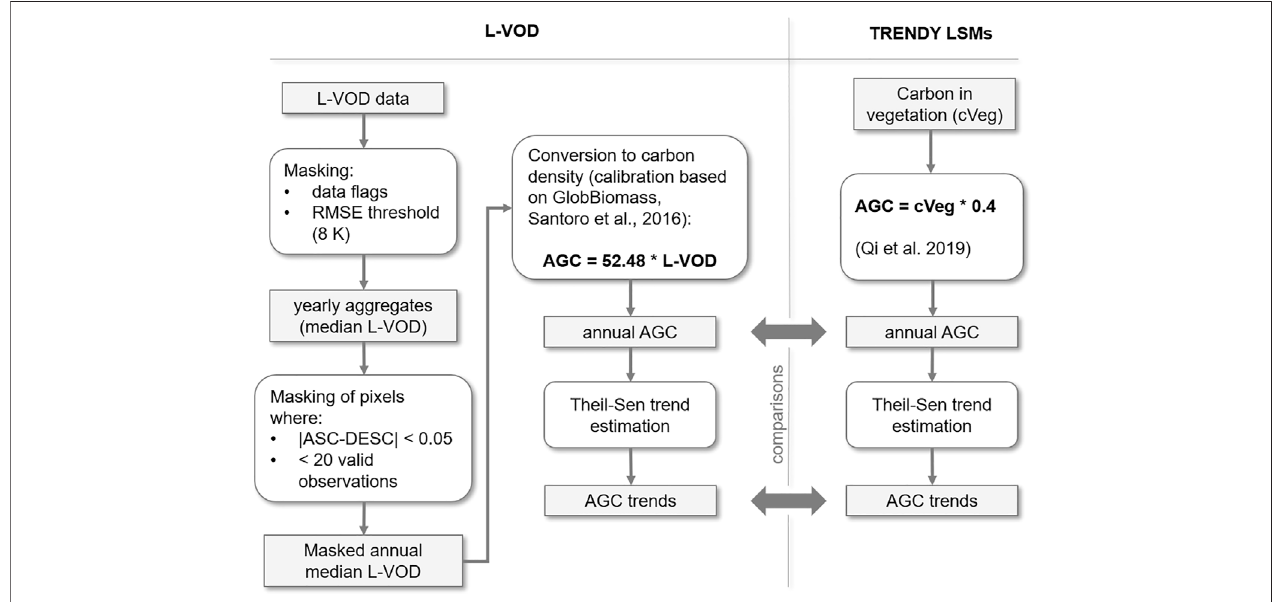
FIGURE 1 | Processing of L-VOD data and TRENDY simulated above ground carbon (AGC) to obtain annual average carbon density and trends. ASC and DESC refer to ascending and descending L-VOD data. Bold arrows indicate products compared.